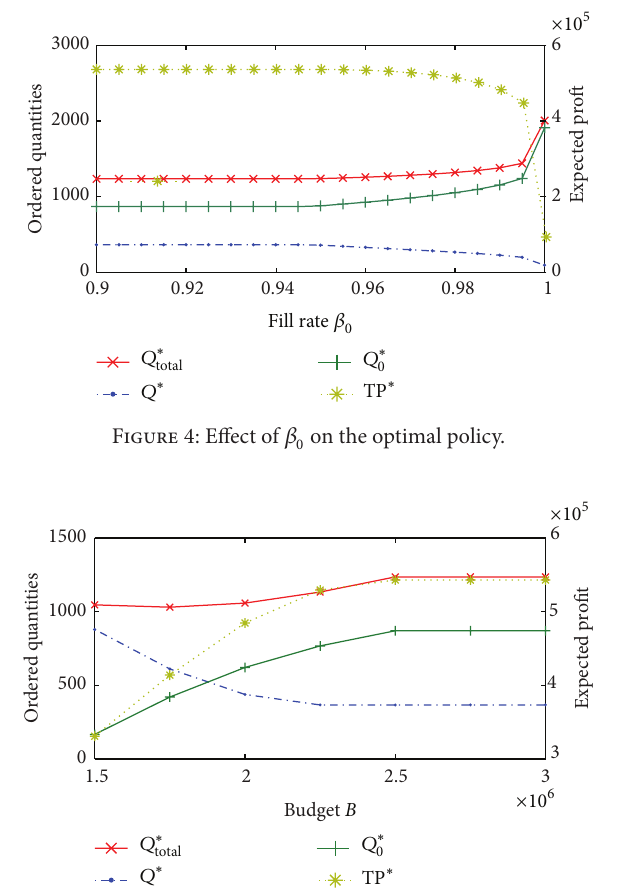
Figure 5: Effect of 𝐵 on the optimal policy.